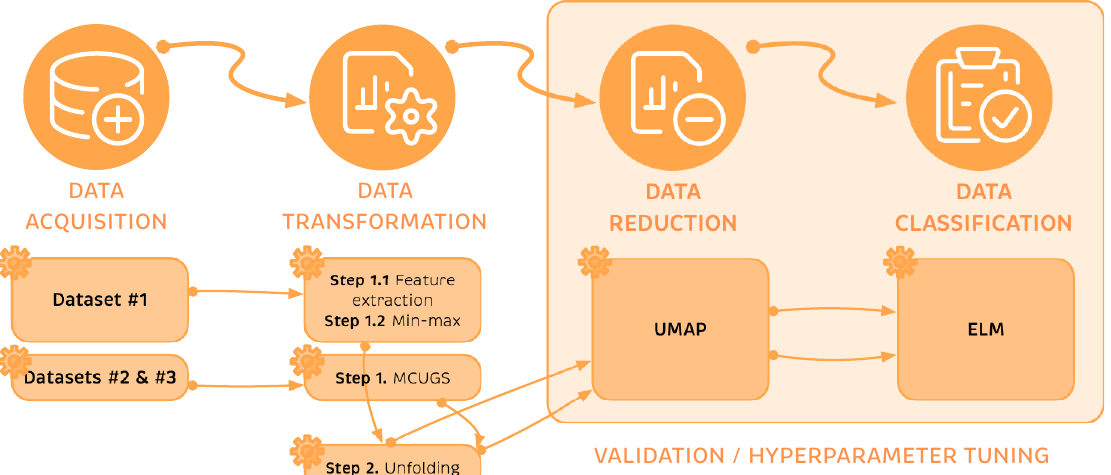
Figure 1. The data classification methodology for ENs(Electronic Noses) is divided into four stages: Data acquisition, data transformation, data reduction, and data classification. MCUGS, mean- centered unitary group-scaling; UMAP, uniform manifold approximation and projection; ELM, extreme learning